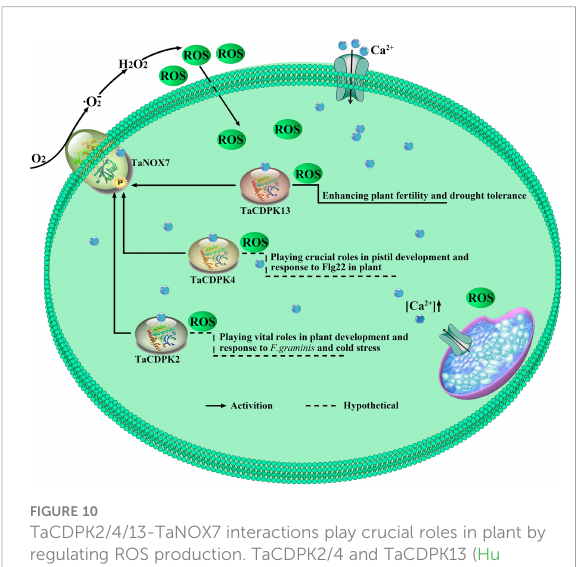
FIGURE 10 TaCDPK2/4/13-TaNOX7 interactions play crucial roles in plant by regulating ROS production. TaCDPK2/4 and TaCDPK13 (Hu et al., 2020a) can interact with and activate TaNOX7 for ROS production, which plays crucial roles in plant